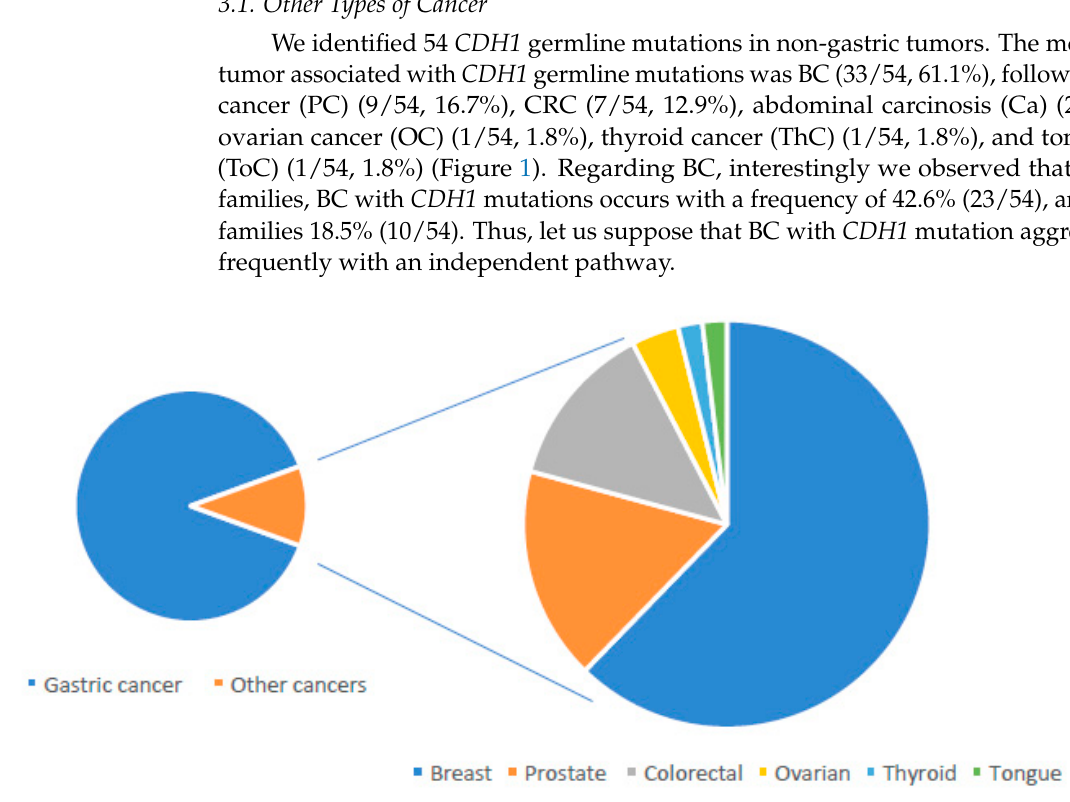
Figure 1. Frequency of CDH1 germline mutations in gastric cancer and other cancers (cancers in detail are shown in the second pie).